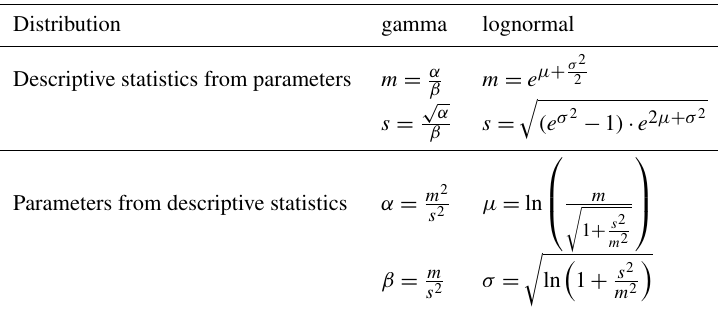
Parameters from descriptive